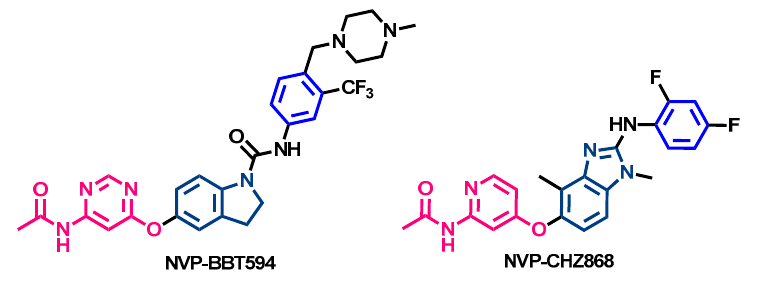
Figure 4. JAK2 inhibitors, NVP-BBT594 and NVP-CHZ868.